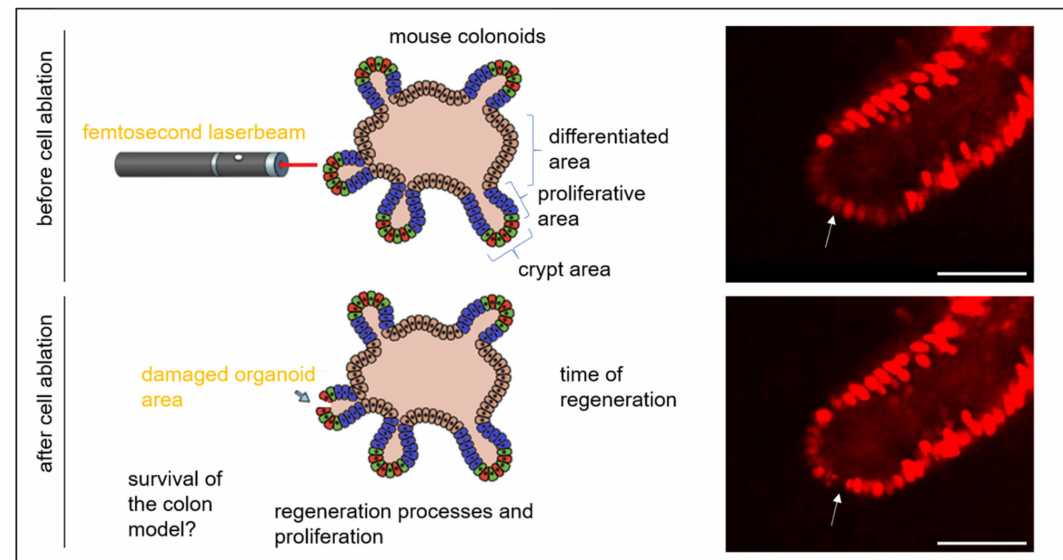
Figure 1. Femtosecond laser-based nanosurgery was used to remove single cells within the colonoid, which is divided into three areas, the crypt zone, the proliferative zone, and the differentiated zone. Via nuclear labeling (mCherry-H2a), the response of the colonoid to the damage of the epithelium was tracked in terms of repair, viability, and proliferation. The white arrow indicates the location of the ablated cell in a multiphoton microscopy image. The scale bar corresponds to 50 µ